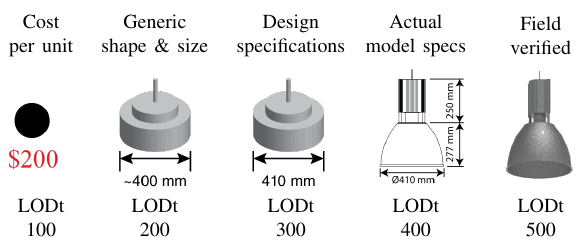
Figure 4. Example of LODts for a light fixture. Models for LODts 400 and 500 courtesy of the Luminaires Group.